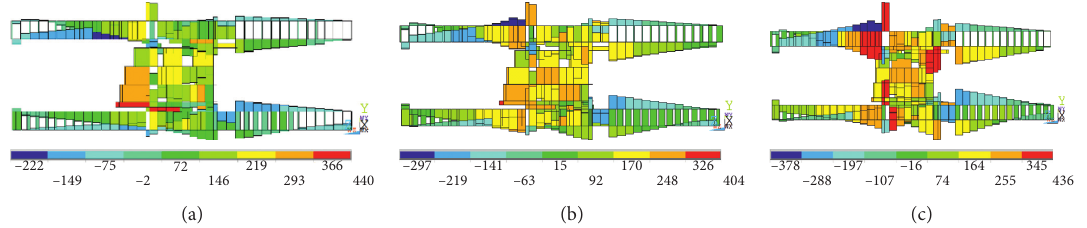
Figure 30: The steel bar stress distribution under failure mark 2. (a) The steel bar of FE1. (b) The steel bar of FE1. (c) The steel bar of FE1.